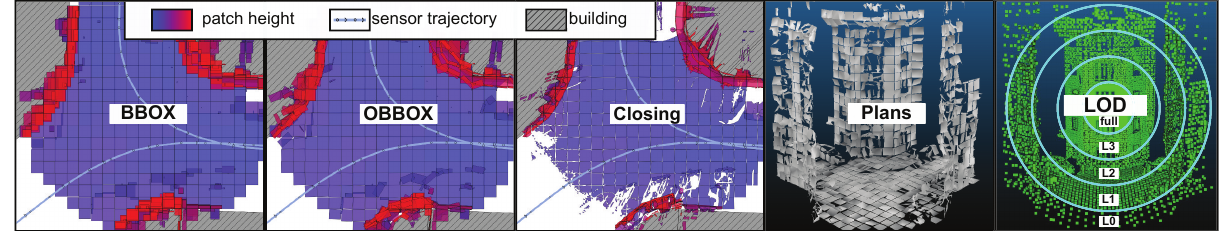
Figure 9: Bounding Box, Oriented BBox, spatial closing. Closing on 3D plan detection. Level Of